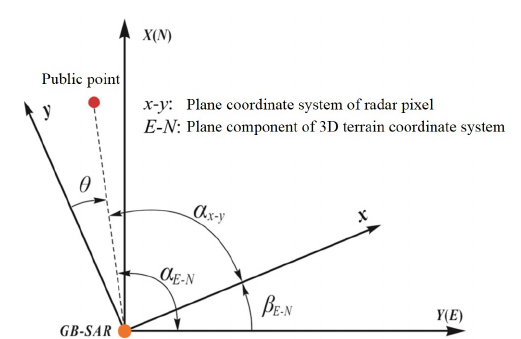
Figure 1. Relationship between coordinate axes and horizontal angle